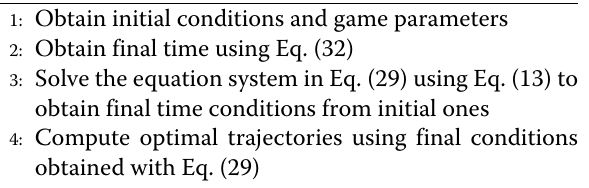
Algorithm 1 Steps for the analytical